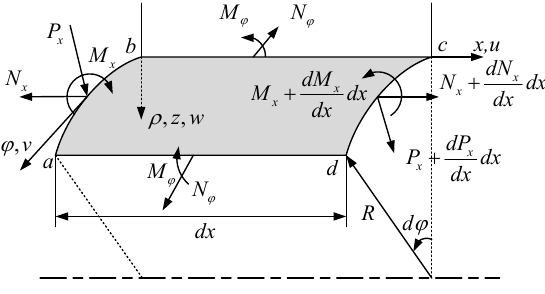
Figure 2. A thin ‐ walled cylindrical shell in the cylindrical coordinates. Figure 2. A thin-walled cylindrical shell in the cylindrical